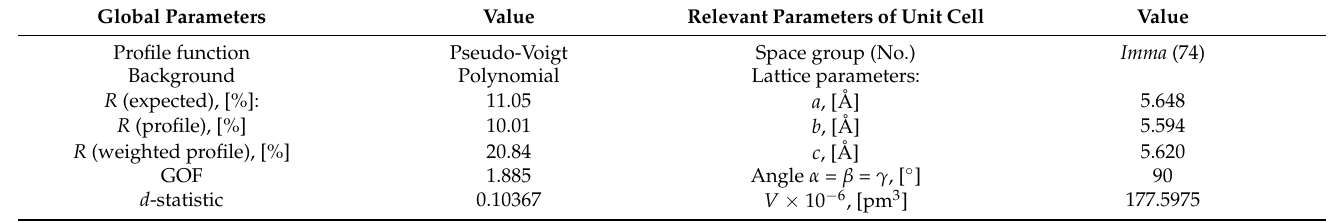
Table 1. Results of the unit cell search calculations for the “upgraded” (x = 5-4-3) BST thin film.